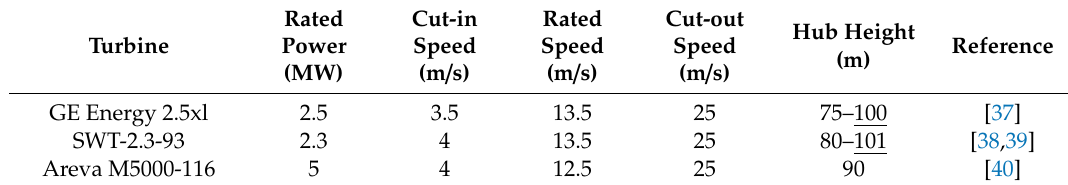
Table 1. Main specifications of the wind turbines considered for evaluation.